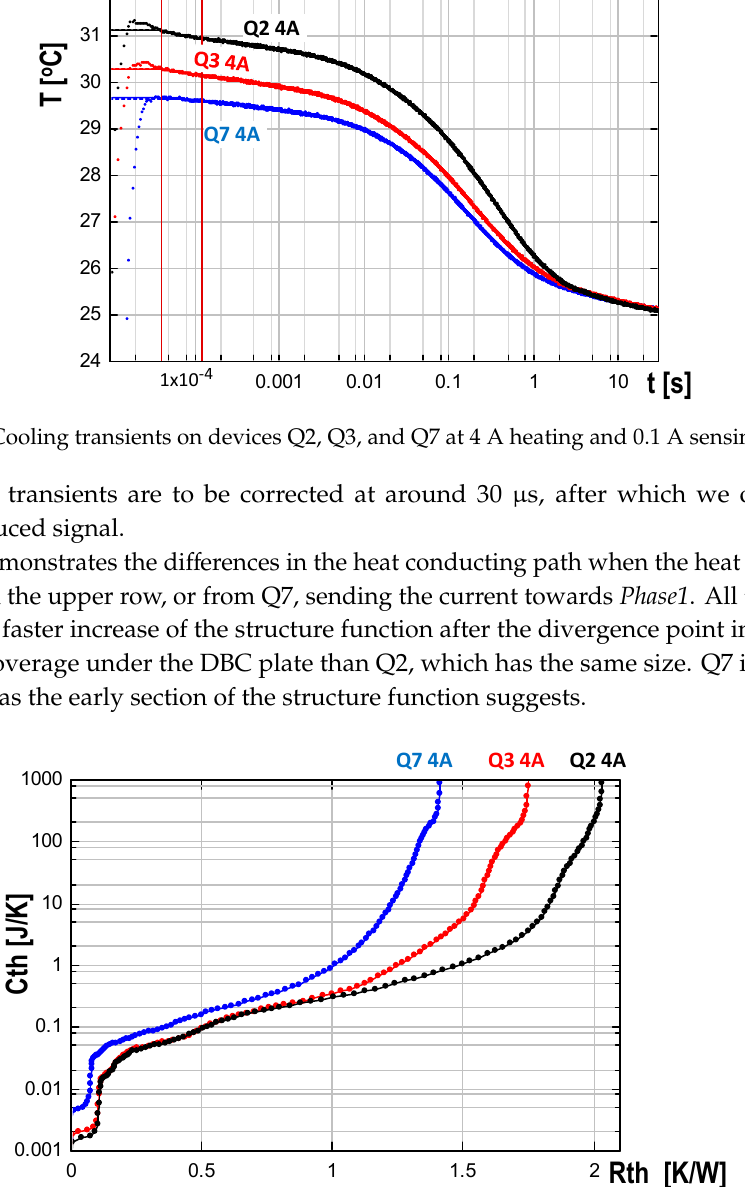
Figure 27. Circuit scheme of an automotive Engine Control Unit module.